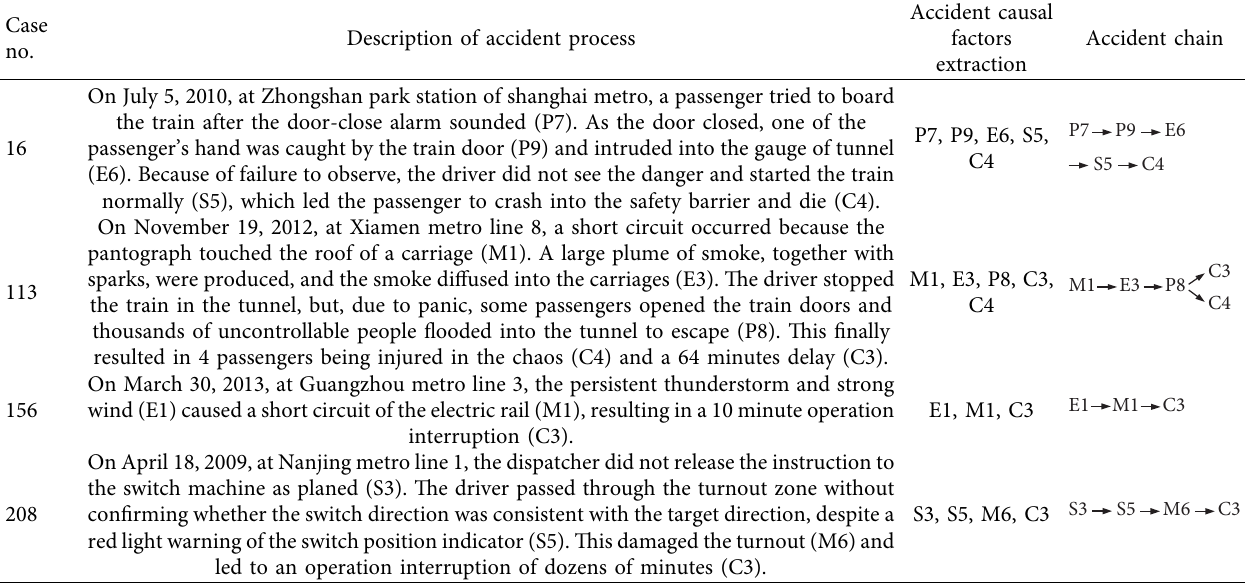
Table 2: Typical cases for establishing the accident